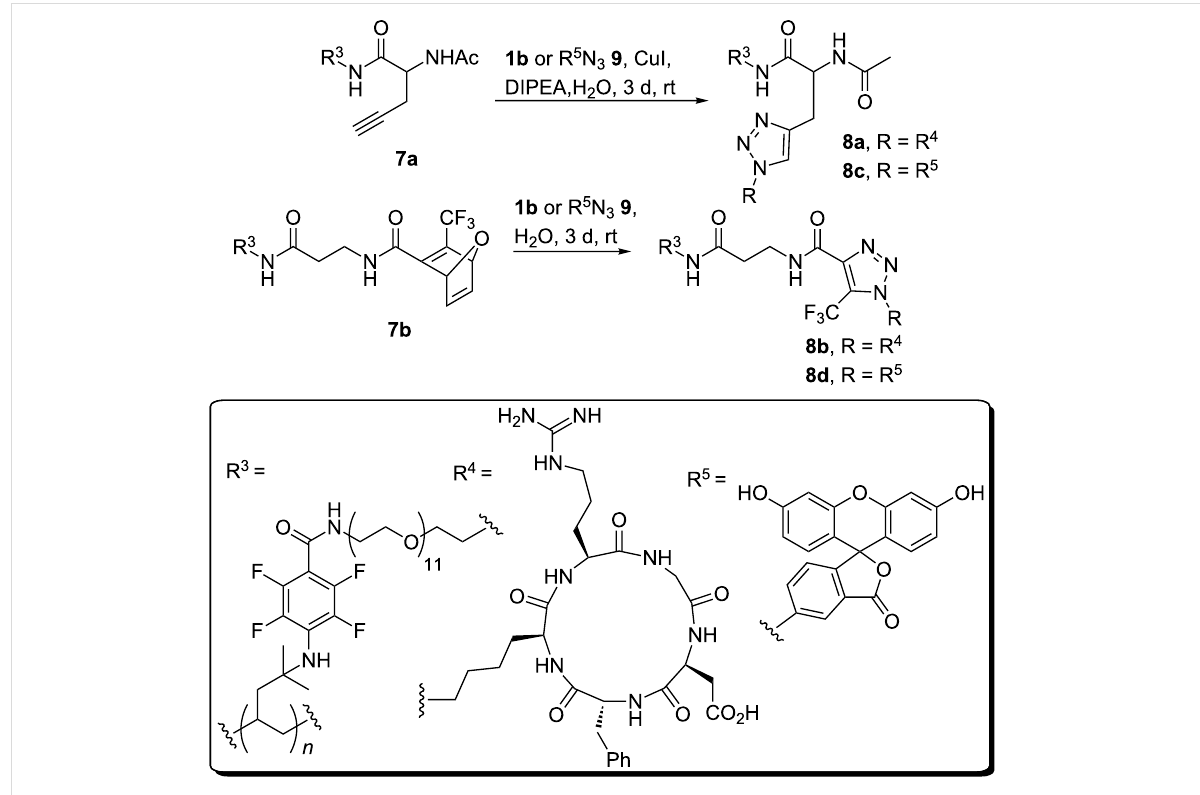
about 515 nm (dotted line versus dashed line) compared to starting TPX 7a